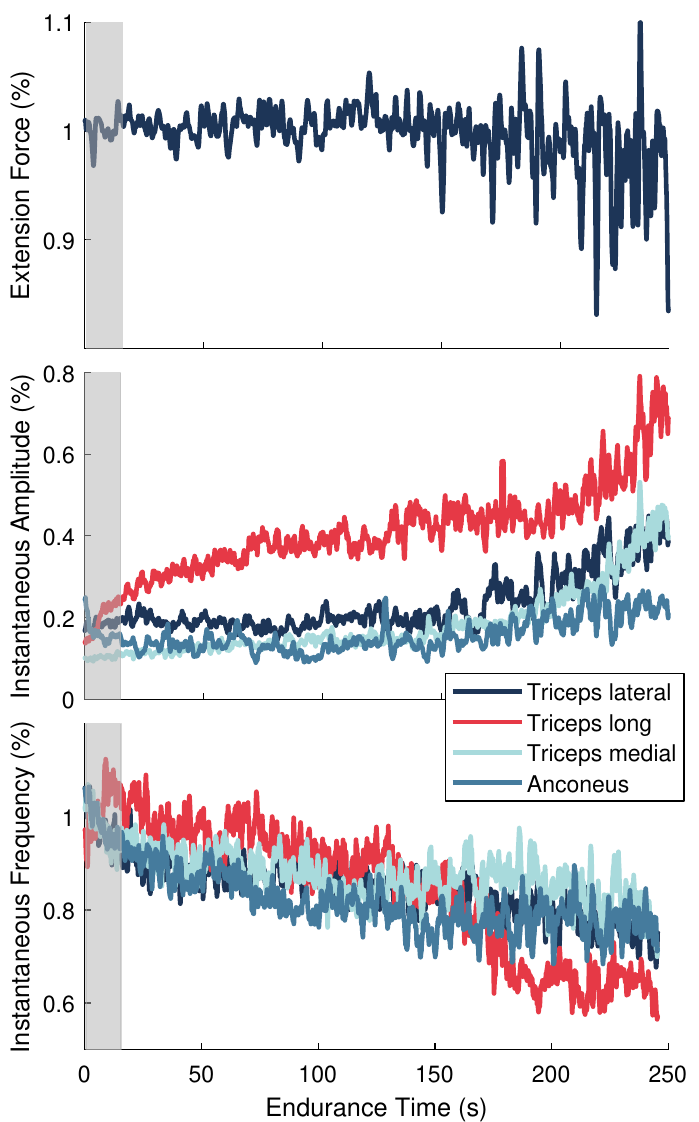
Figure 3. Normalized signals for a single representative participant during the endurance task. ( Top ) Elbow extension force. ( Middle ) Instantaneous amplitude ( a i ( t ) ) and ( Bottom ) instantaneous frequency ( f im ( t ) ) features for the elbow extensor muscles. Gray shaded area signifies the training data